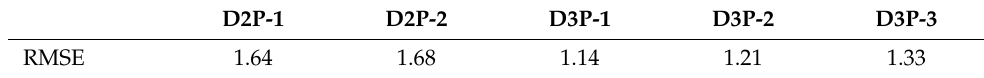
Table 3. Root Mean Square